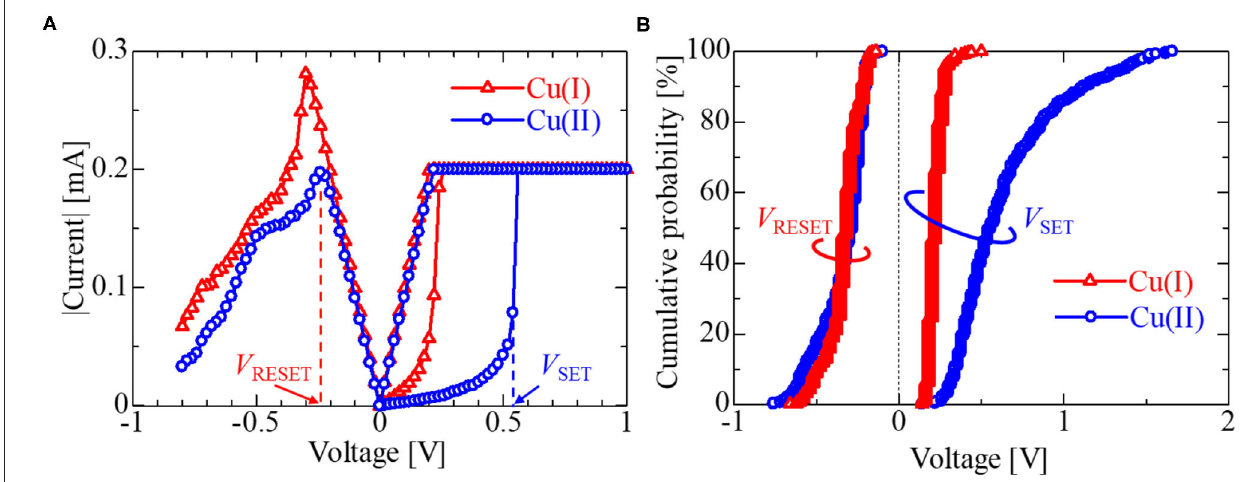
FIGURE 8 | (A) I – V characteristics and (B) cumulative probabilities of Cu(I)-IL-Memristor and Cu(II)-IL-Memristor. Red and blue plots, respectively corresponds to the data obtained from Cu(I)-IL-Memristor and Cu(II)-IL-Memristor. V SET was defined as the voltage value just before the measured current reaches the current compliance value ( I comp ). V RESET was defined as the voltage at which the current value in the RESET process is maximized. The red and blue vertical dotted lines in (A) indicated the V RESET and V SET values for the case of Cu(II)-IL-Memristor shown as an example. Under the negative voltage, only the voltage scan from the origin to the negative direction was conducted in order to avoid the excessive voltage stress (For more detail, see Supplementary Material ).